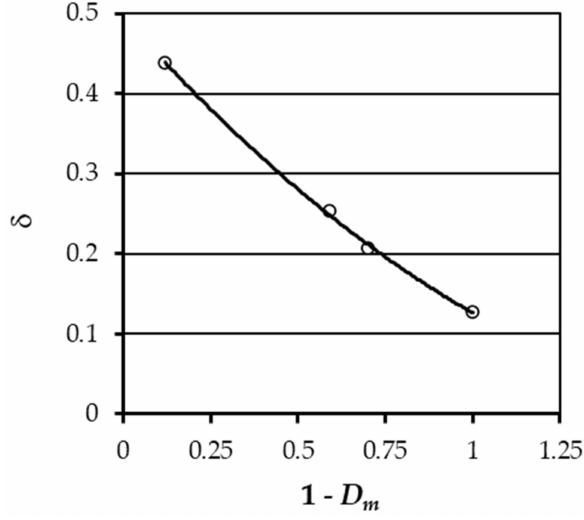
Figure 5. Relationship between the δ values, corresponding to a concentration of 0.054, and the particle size D m , for sand